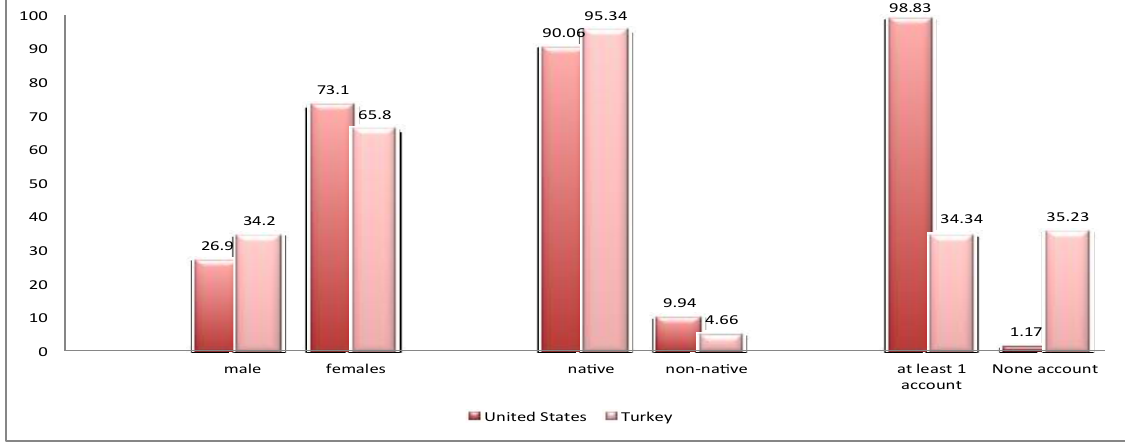
Graph 1. Independent Variable Frequency by